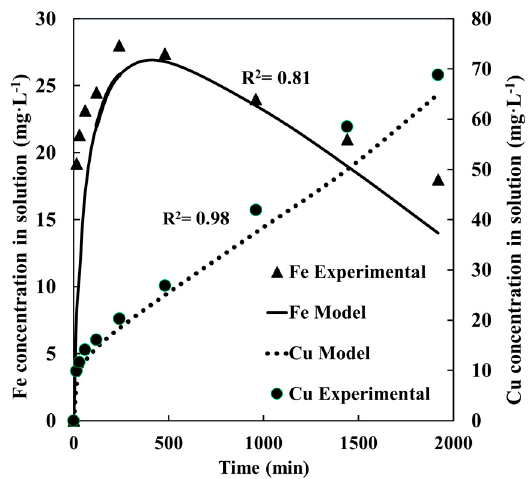
Figure 5. Iron and copper concentrations in solution for the pyrite + chalcopyrite leaching system.